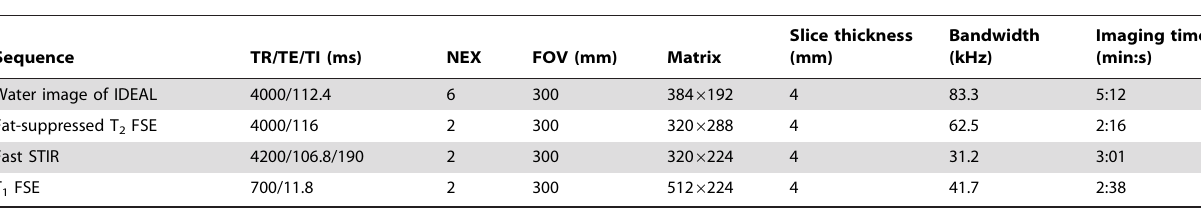
Table 1. Acquisition parameters for MR sequences.